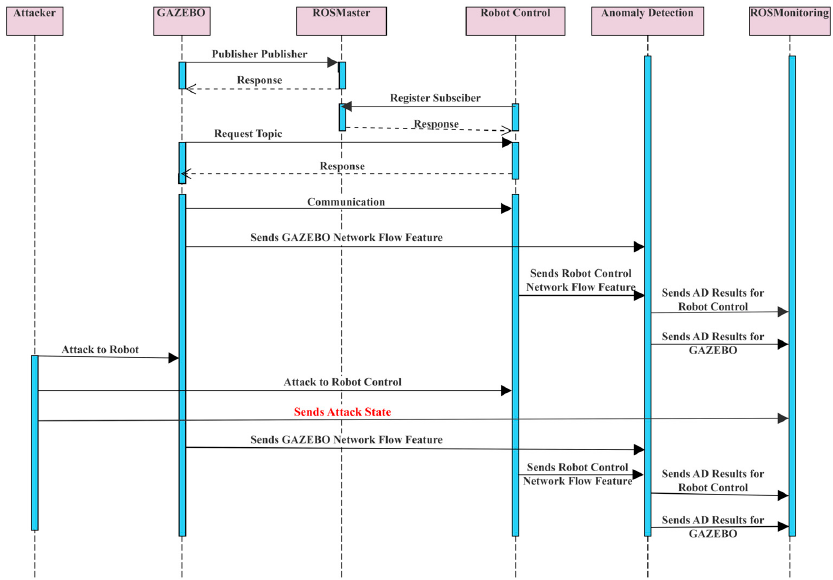
Figure 2. A sequence diagram of runtime verification architecture communication flow.